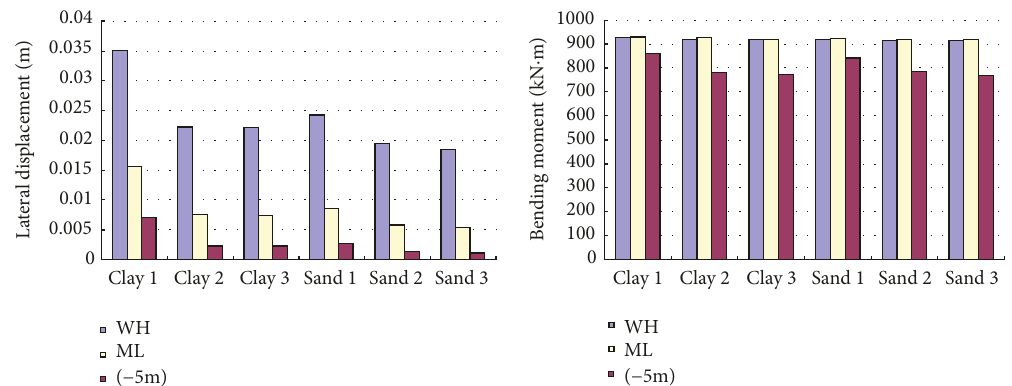
Figure 13: Effect of the soil properties at wellhead, mudline, and − 5m on